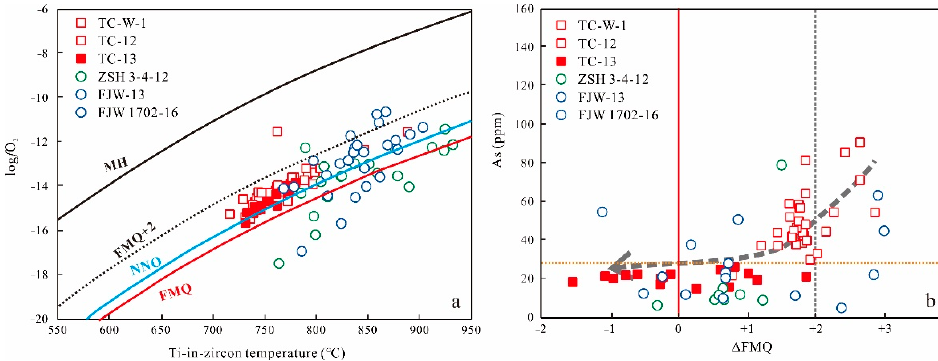
Figure 8. Diagrams of ( a ) Ti-in-zircon temperatures ( ℃ ) vs. log f O 2 and ( b ) apatite As vs. Δ FMQ, the Δ FMQ calculated by apatite Mn contents.